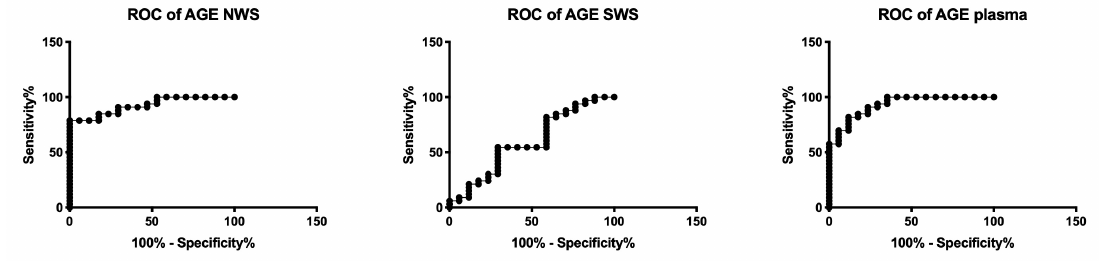
Figure 7. Receiver operating characteristic (ROC) analysis of AGE in non-stimulated and stimulated saliva as well as plasma of NYHA II and NYHA III patients. Abbreviations: AGE—advanced glycation end products; NWS—non-stimulated whole saliva; NYHA II—class II in the New York Heart Association (NYHA) classification of the heart failure; NYHA III—class III in the New York Heart Association (NYHA) classification of the heart failure; SWS—stimulated whole